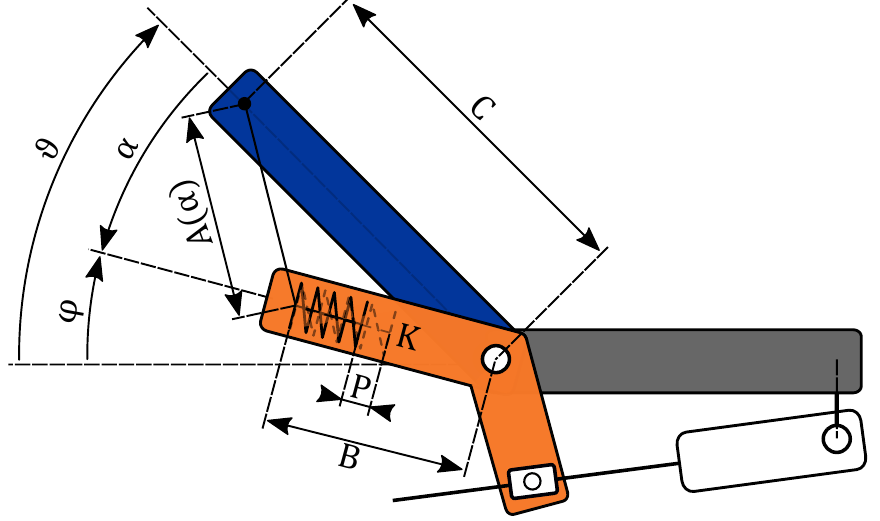
Figure 1. Schematic drawing of the spindle-driven MACCEPA principle with its parameters. The input link (grey) is usually the fixed one and therefore serves as a reference for the angular positions of the output arm (blue) and lever arm (orange), ϑ and ϕ , respectively. The latter two are connected through an elastic element (spring K ). The motor actuates the lever arm through a spindle drive, therefore creating a deflection angle ( α ) between the lever arm and the output arm. As a result, the spring is compressed, generating a torque around the output link rotation axis. Such a torque pulls the output arm back to its new equilibrium position, aligned with the lever arm ( α = 0). The stiffness of the actuator can be tuned by adjusting the pre-compression of the spring P